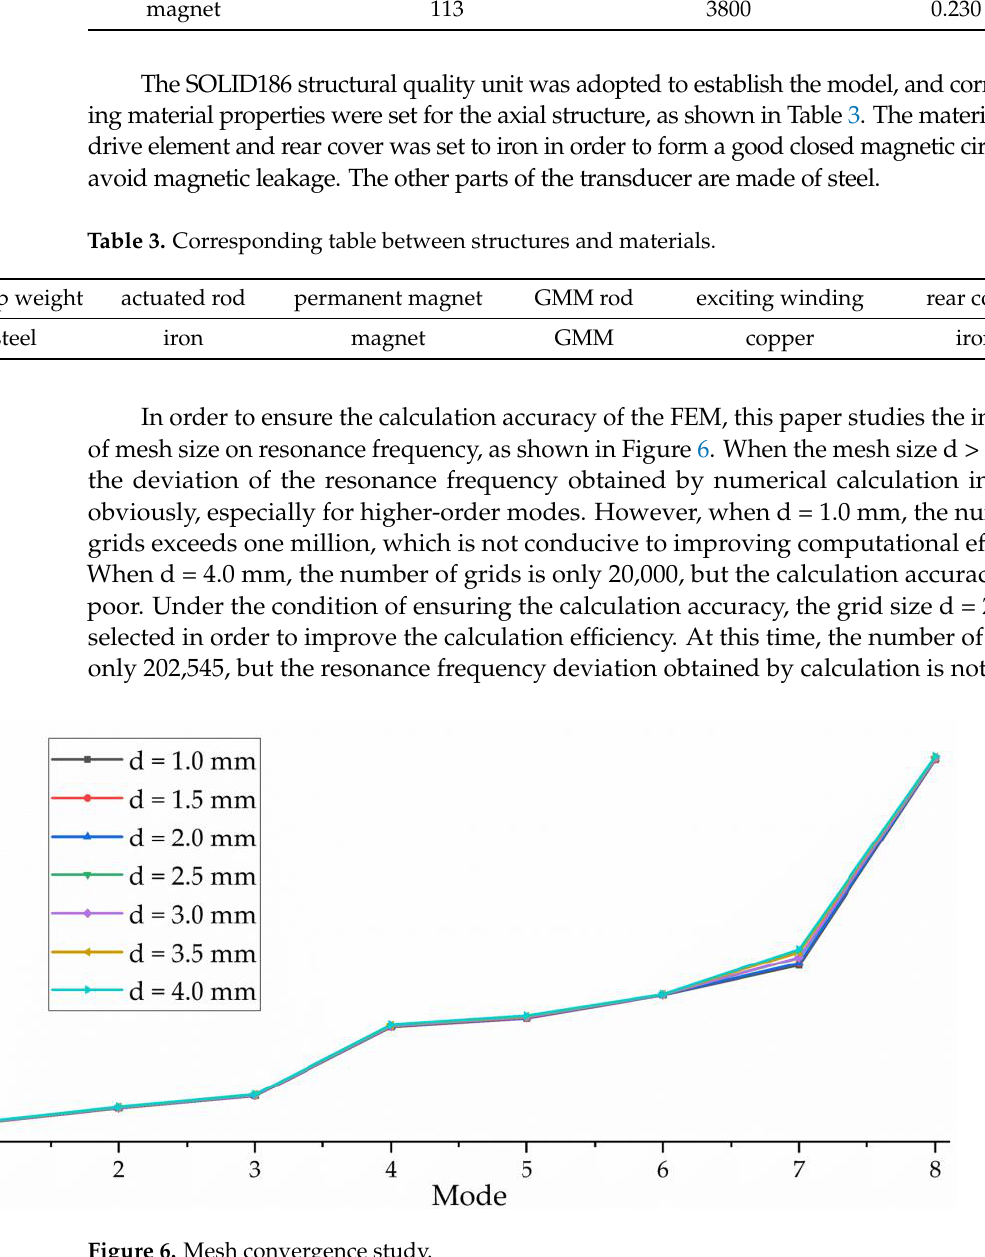
Table 2. Material parameters.